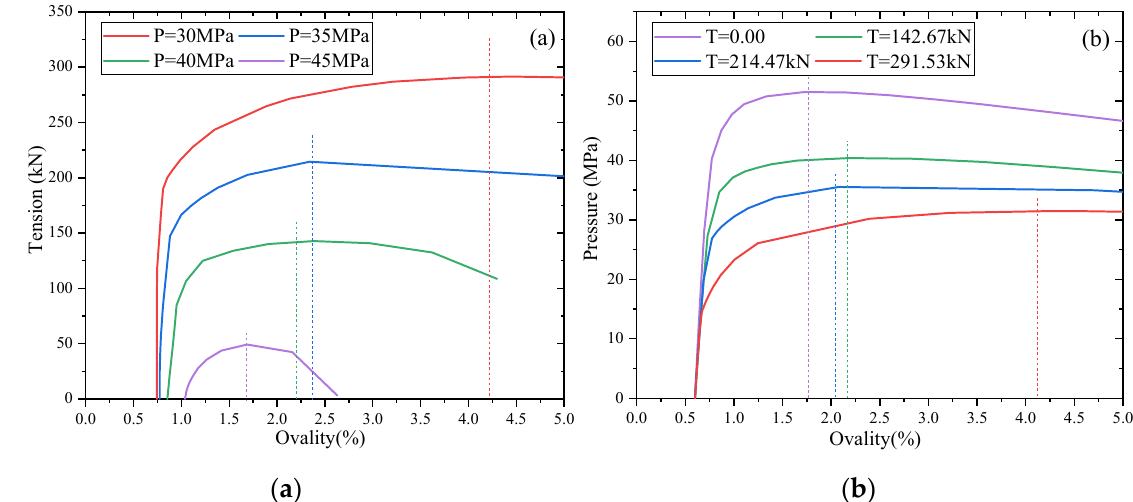
Figure 10. Ovality changing history of the outer pipe. ( a ) P → T loading path; ( b ) T → P loading path.